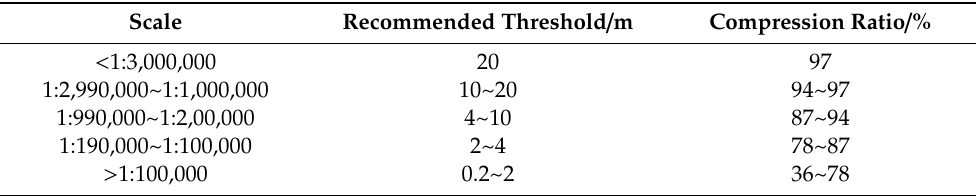
Table 1. Recommended thresholds in different scales.